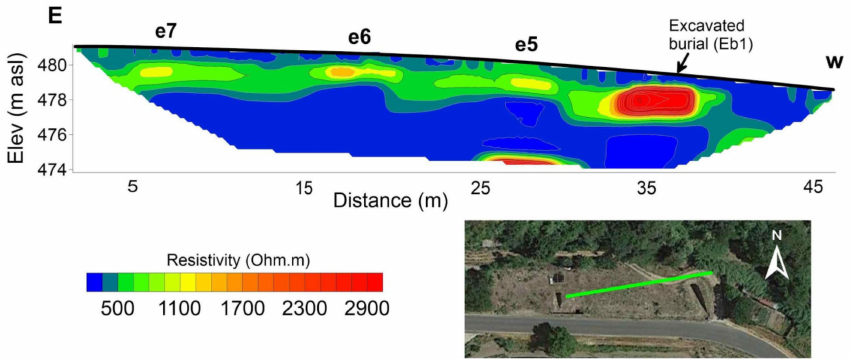
Figure 5. ERT resistivity section. Electrical resistivity tomography (ERT) recovered resistivity model. Root mean square (rms) 2.5% after six